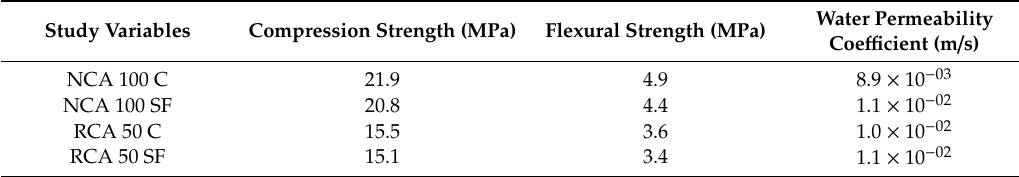
Table 5. Properties of